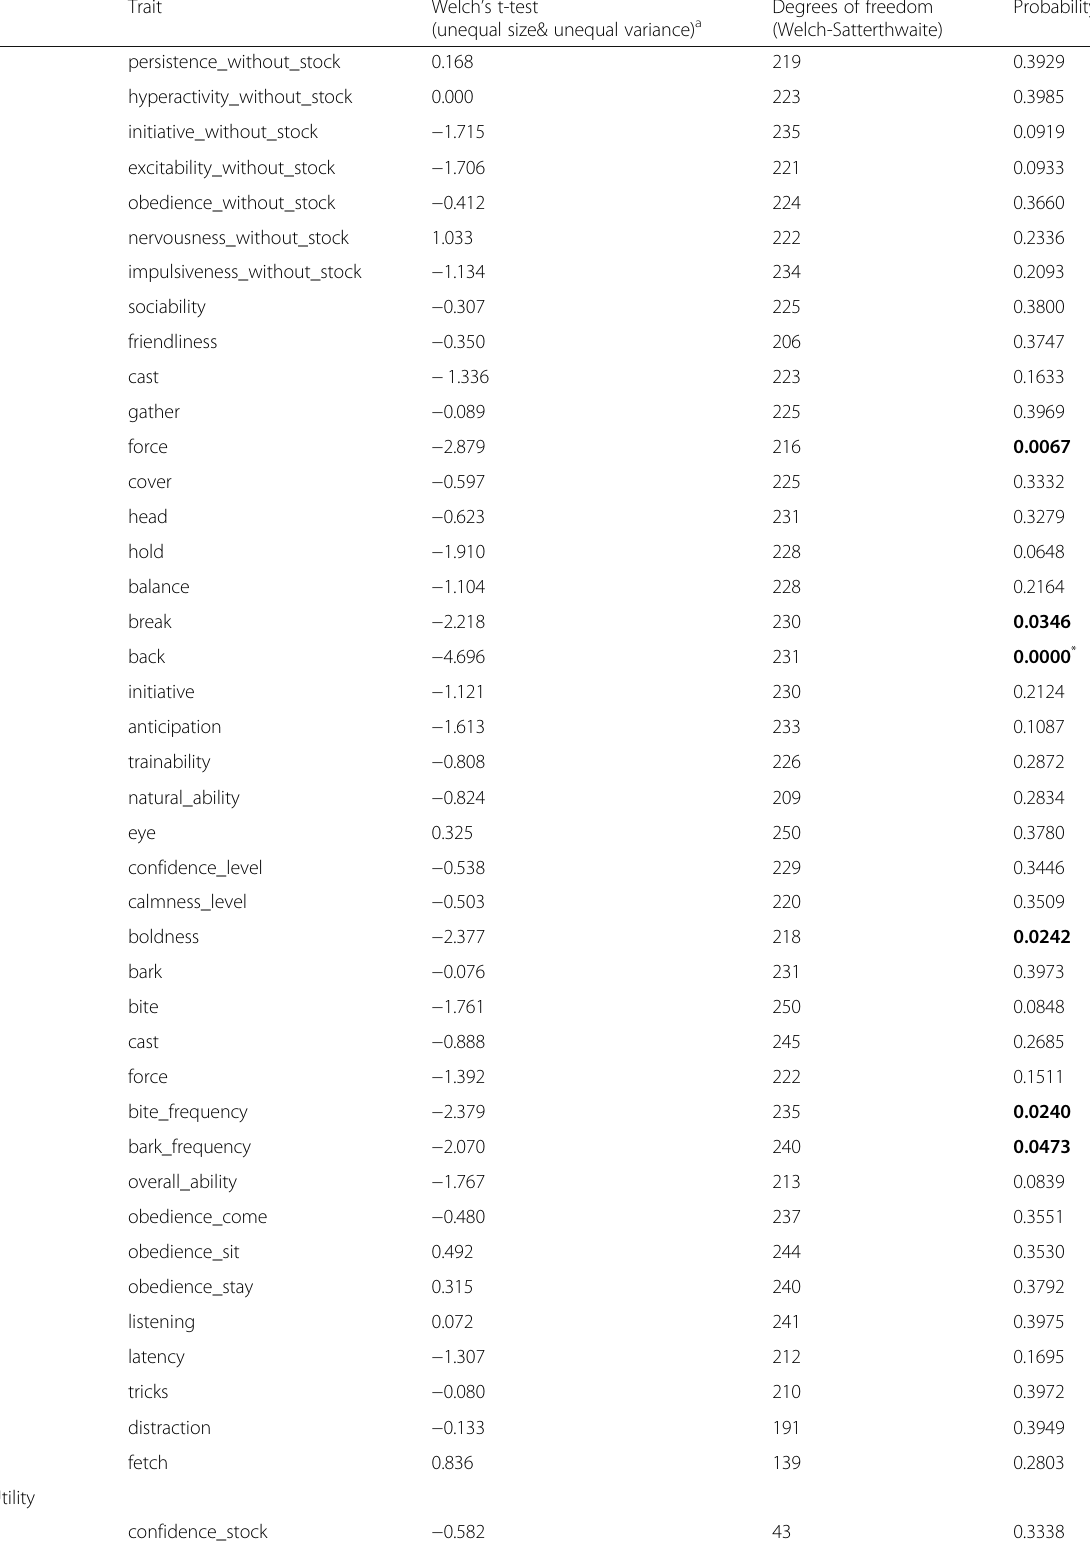
Table 1 Pairwise comparison of work-type in the Australian Working Kelpie over 63 traits (Continued)